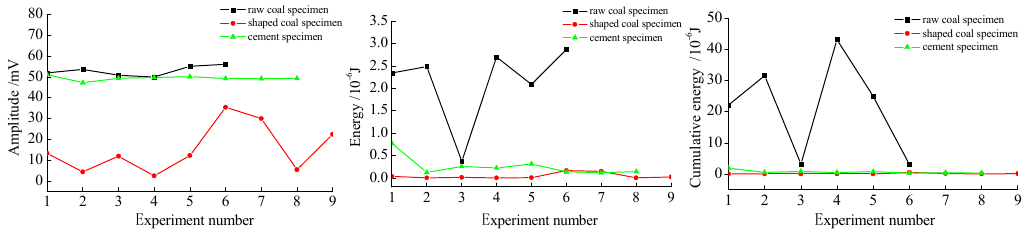
Figure 24. Amplitude, energy and cumulative energy of 1# MS sensors.